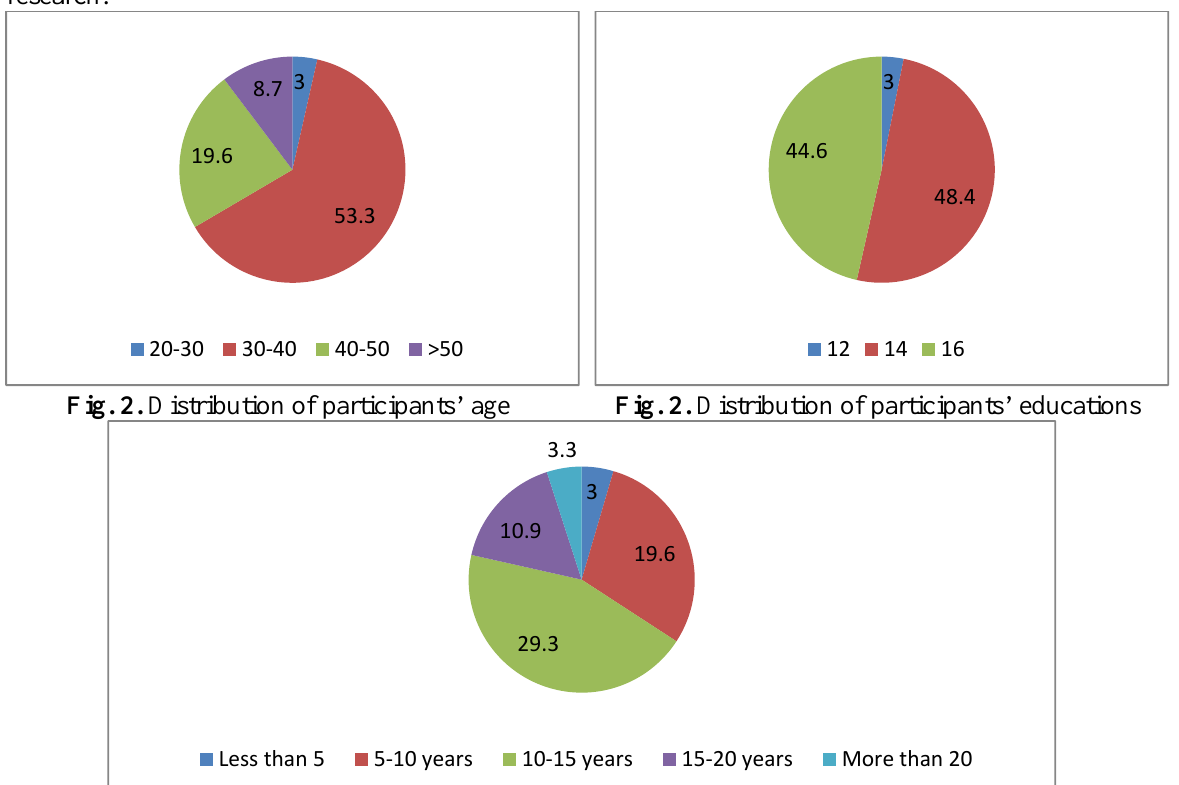
Fig. 4. Distribution of participants’ years of